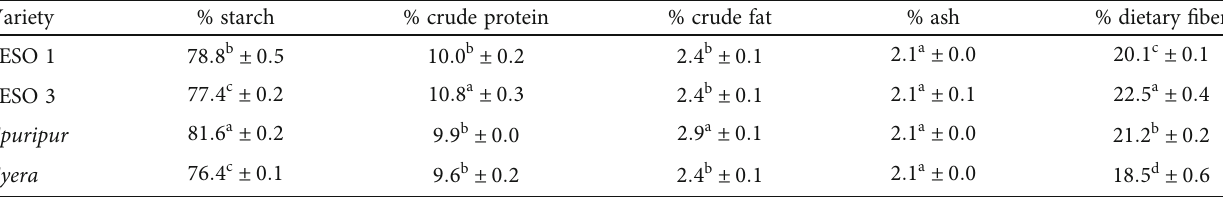
Table 2: Proximate composition of grain sorghum varieties.